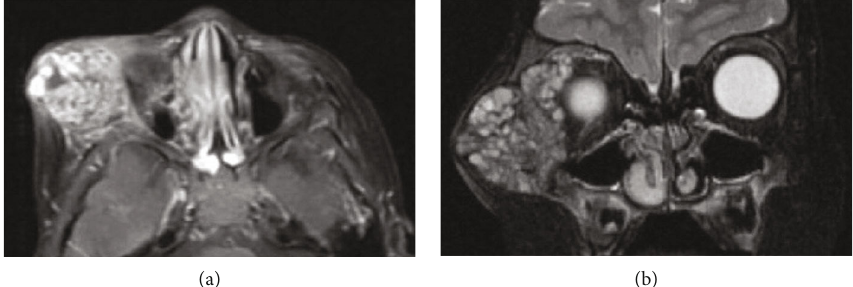
Figure 3: (a) Axial T1-weighted postcontrast fat-saturated magnetic resonance (MR) image shows avid heterogenous enhancement of the soft tissue and intraosseous components. (b) Coronal T2-weighted fat-saturated noncontrast MR image shows the mass with multiple septations/cystic components.